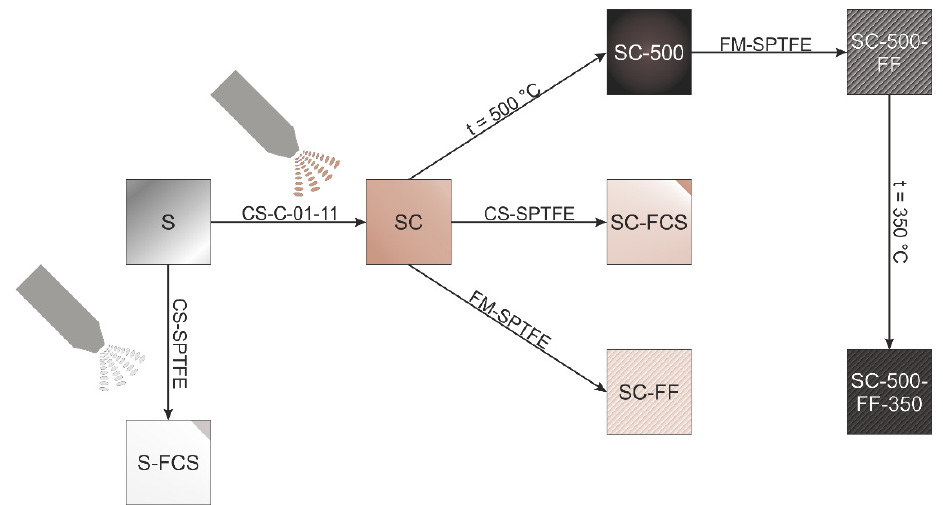
Figure 1. Scheme of sample preparation: CS—cold spray; FM—friction treatment; C-01-11—copper and zinc powder (DIMET ® ); SPTFE—super-dispersed polytetrafluoroethylene (FORUM ® ). Designa- tion of samples is given in the text and Table 2. Table 2. Designation of the sample with different coatings formed on St3 steel. Sample